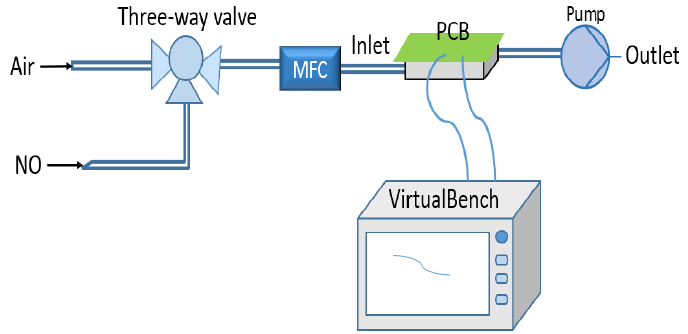
Figure 8. Gas sensing test system.